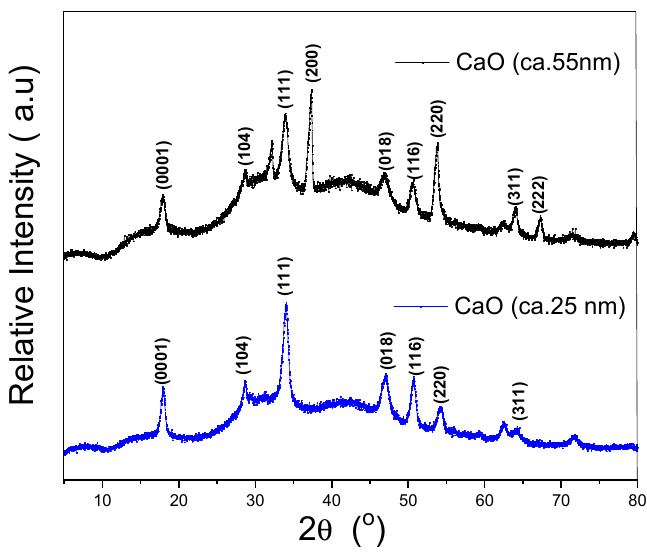
Figure 2. XRD analysis of CaO nanoparticles.